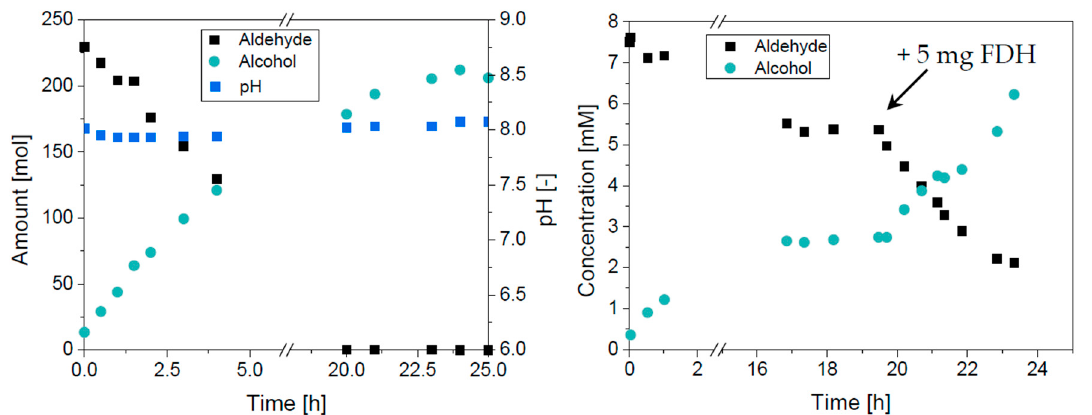
Figure 3. Reaction progress of the aqueous phase with in situ cofactor regeneration. Conditions: left: potassium phosphate buffer pH 8, 0.1 M, V = 25 mL, c Aldehyde = 7.5 mM (fed with 0.3 mL/h), c NADH = 0.1 mM, m ADH = 3,125 mg, m FDH = 5 mg, c sodium formate = 200 mM, 30 °C. Right: potassium phosphate buffer pH 8, 0.1 M, V = 25 mL, c Aldehyde = 7.5 mM, c NADH = 0.15 mM, m ADH = 0.5 mg, m FDH = 5 mg, c sodium formate = 100 mM, 30 °C.